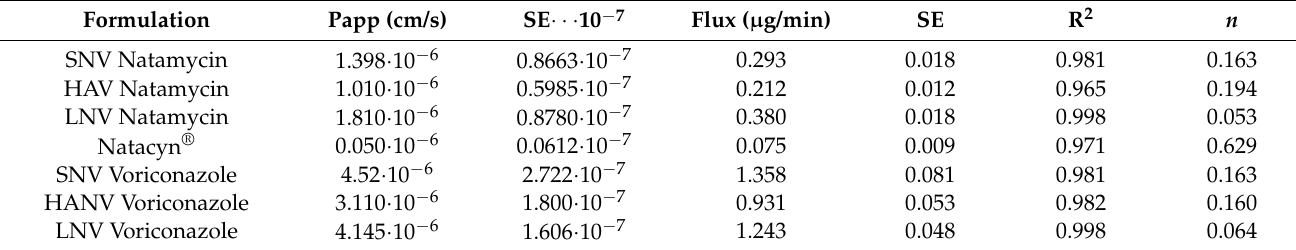
Table 7. In vitro release data from natamycin/voriconazole formulations.